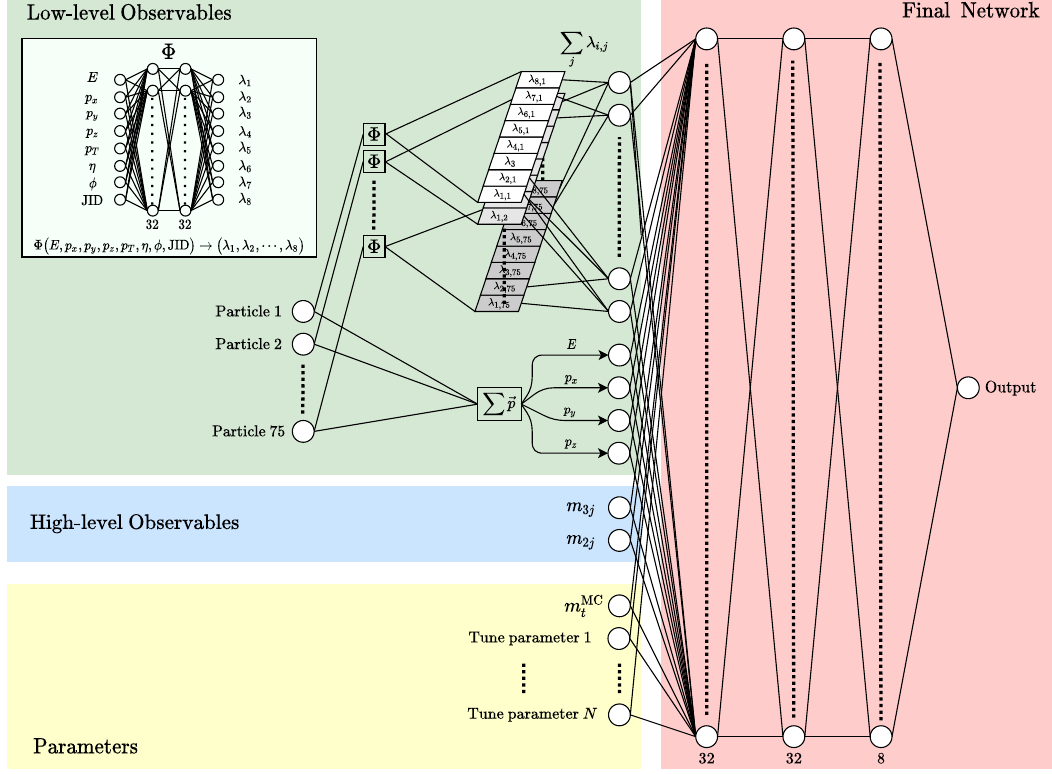
Figure 10. Architecture used to infer the top-quark mass with DCTR. The green portion shows the low-level information from the constituents of the jets. These are combined with a ParticleFlow Network, denoted by Φ acting on each constituent, with the resulting output being summed across the particles. The Φ network is shown in the breakout box. Next are the high-level inputs of the three-jet and two-jet invariant masses, shown in the blue portion. The last elements are the Monte Carlo parameters to be inferred, shown in yellow. All of these are combined in the latent space, which is then connected to the final output with a dense neural network shown in